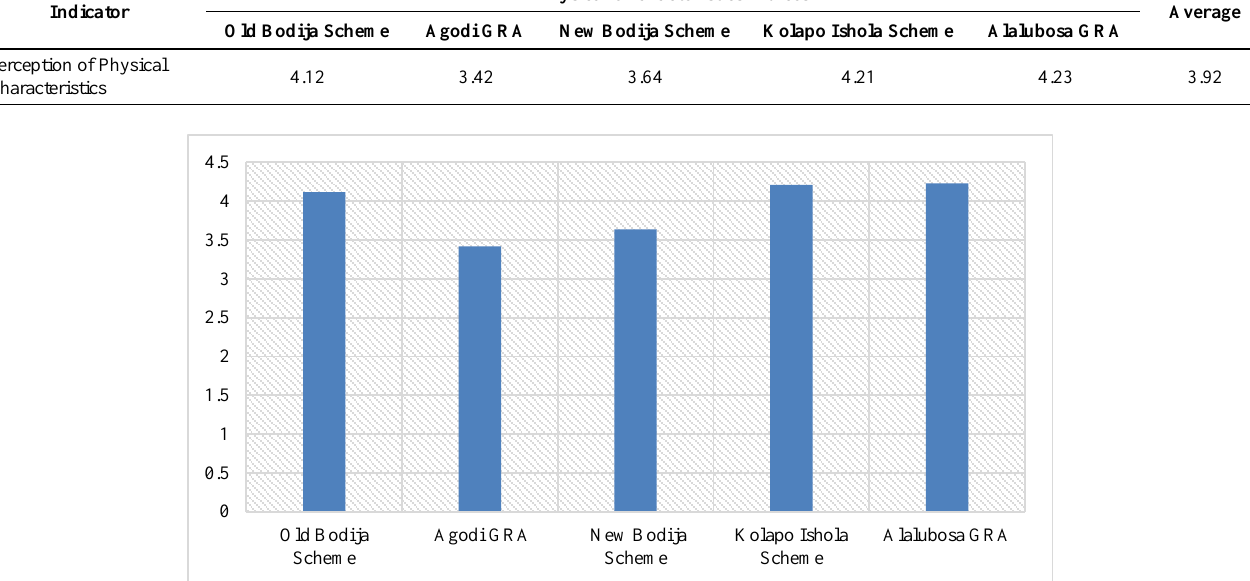
Table 11. Summary of the Perception of the Neighbourhood Physical Quality in the Study Areas Indicator